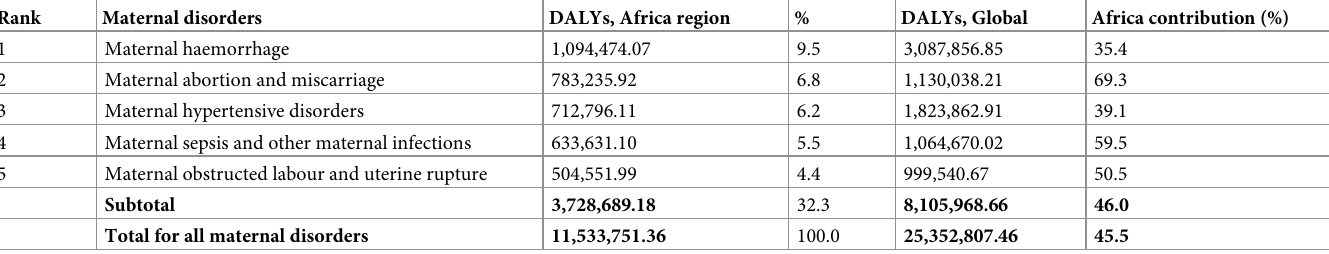
Table 2. Leading maternal conditions in the Africa region, global and African region DALYs contribution, 2019.